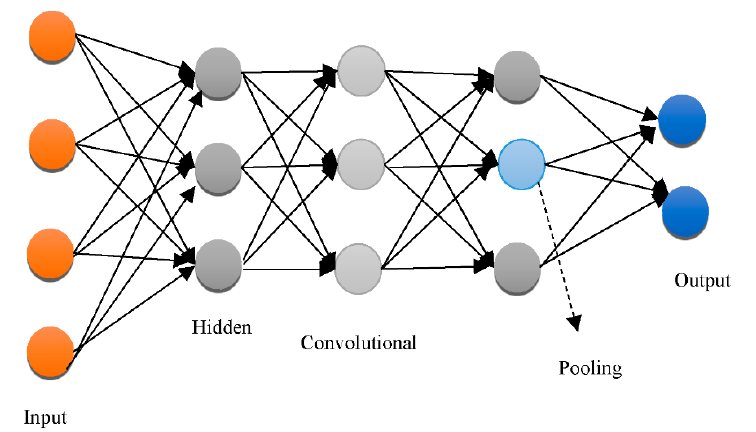
Figure 5. CNN architecture.